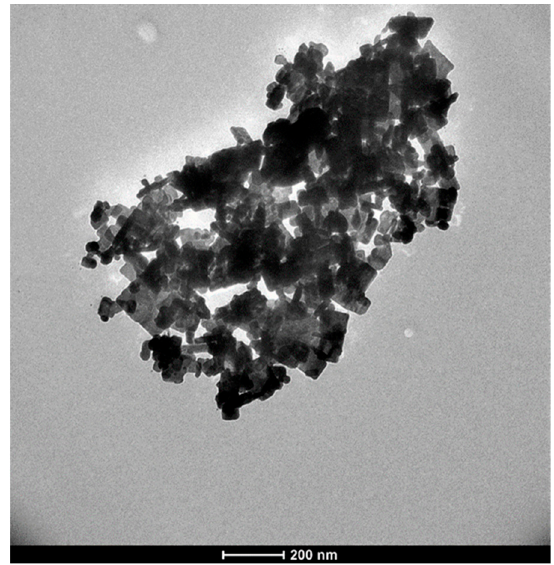
Figure 7. TEM image of Ag 2 Se NPs from sample C 2 prepared in the absence of fructose.